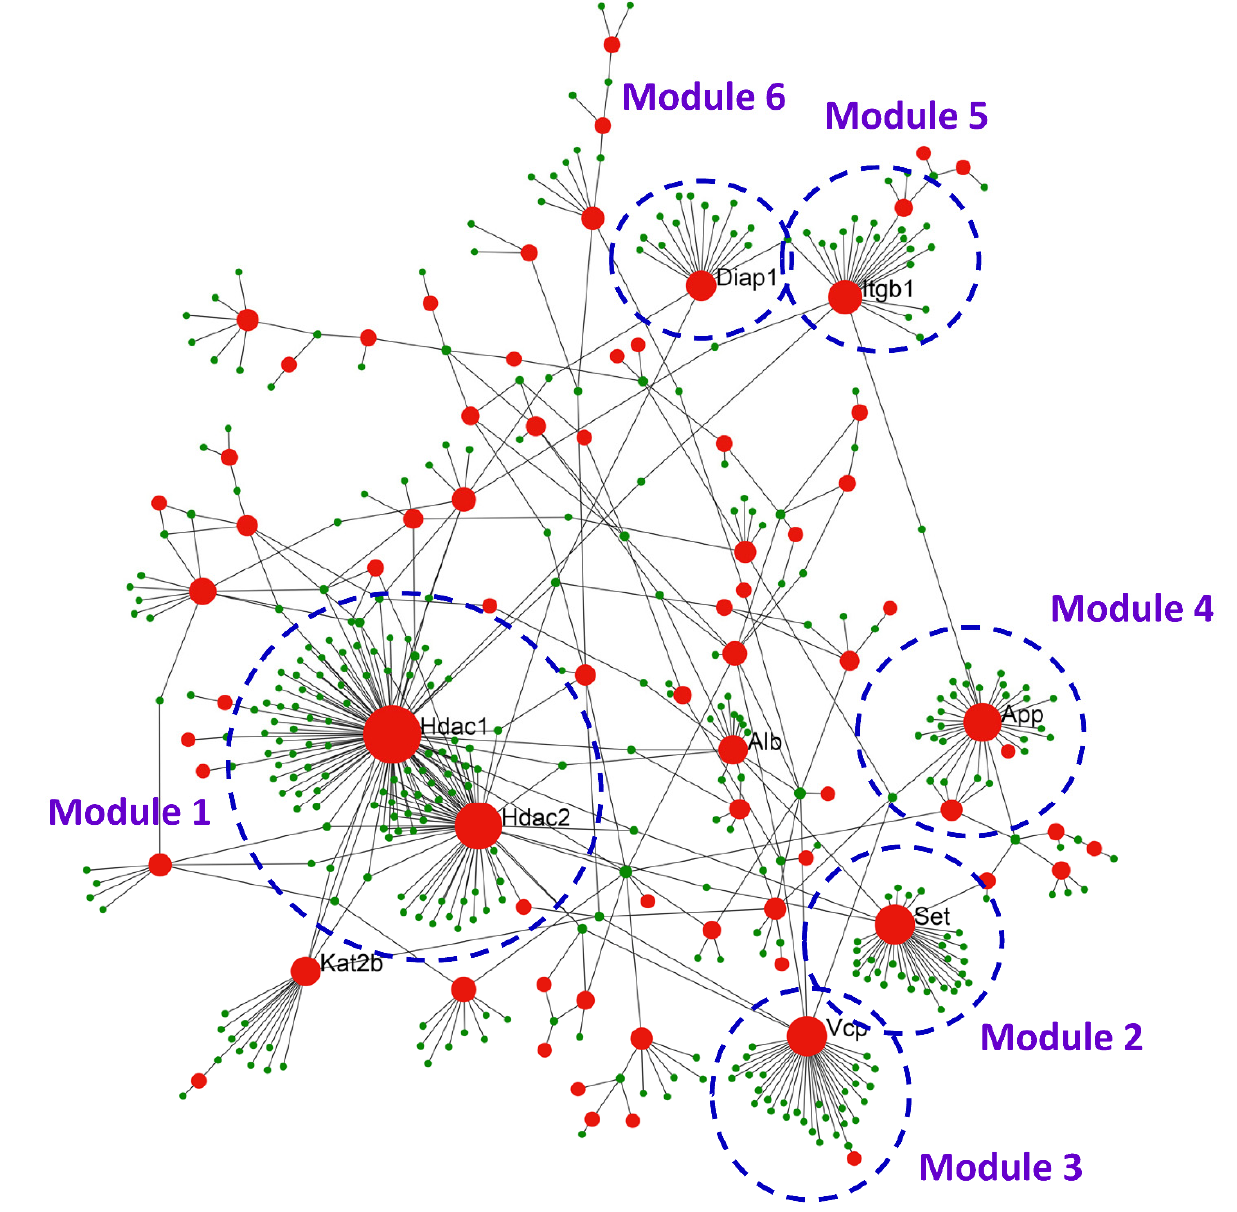
Figure 6. The PPI network of exosomal proteins constructed by Cytoscape presenting the hub proteins, known to possess the highest degree of connectivity among the protein targets, and six key modules network. PPI, protein–protein